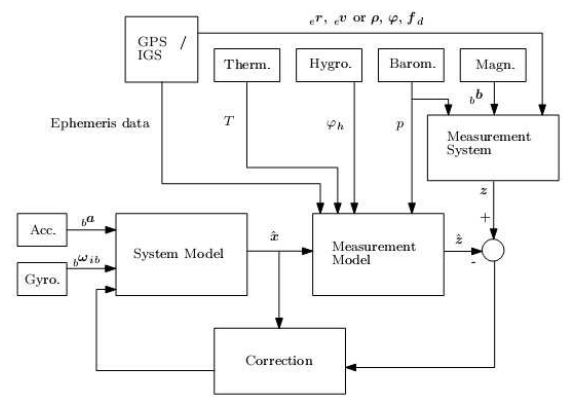
Figure 3: Information flow of the extended Kalman filter sensor system is fixed horizontally on a common mounting